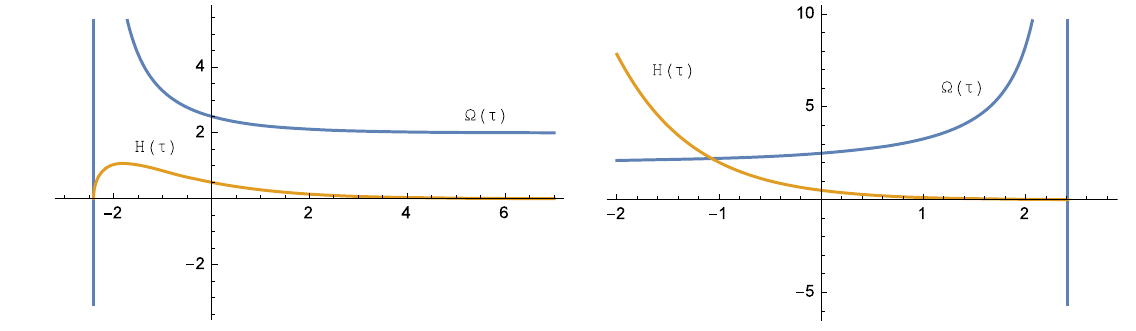
Fig. 1 Solutions (4.2) for γ < − 1 / 2 and γ > − 1 / 2 when (cid:4) 0 >